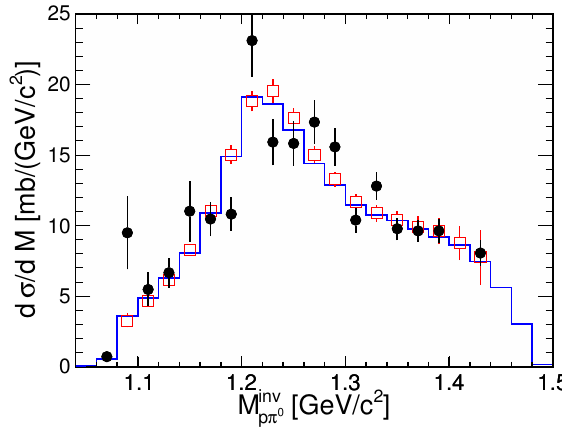
Figure 5. Dielectron data points after acceptance and branching ratio for π 0 → e + e − γ decay corrections (black dots) compared with the data from the exclusive pp π 0 channel (red open squares). The histogram shows total PWA solution (solid blue) obtained for the hadronic